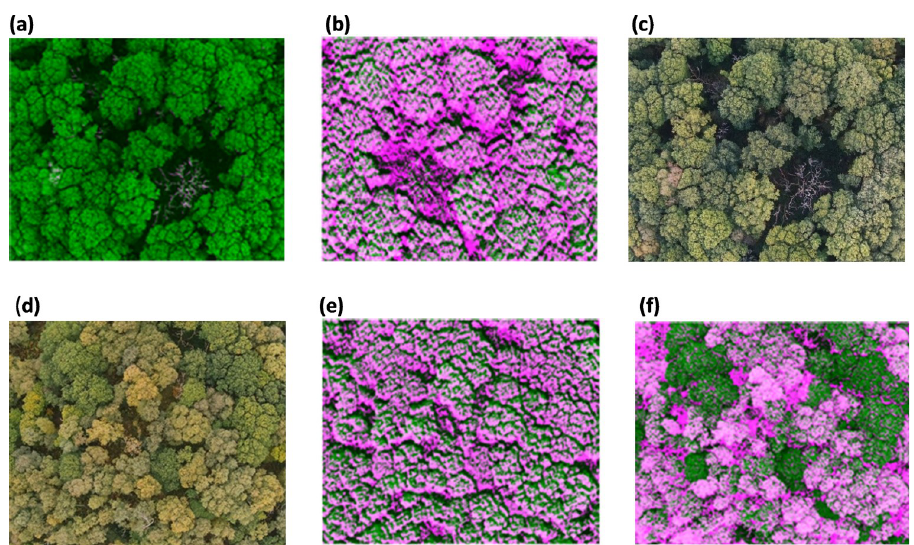
Fig 8. Thresholding Images derived from NDSI for dead trees (a) RGB image, (b) image derived from (PC1-PC2)/(PC1+PC2) (c) image derived from (PC1-PC3)/(PC1+PC3). For silver birch and oak trees (d) RGB image (e) image derived from (PC1-PC2)/(PC1+PC2) (f) image derived from